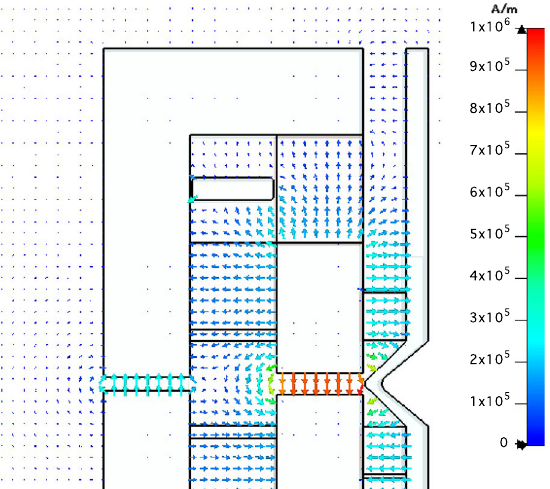
FIG. 5. Magnetic field (H) distribution at the central cross section in the beam